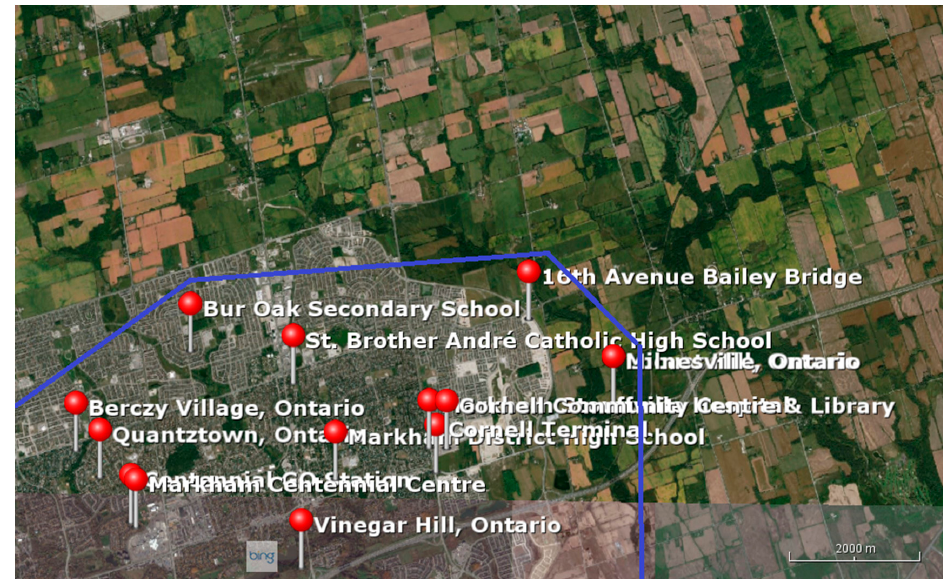
Figure 4. Fusion of multiple layers from different WMS servers: ( a ) LandSat7 photograph of Toronto, ( b ) OpenStreetMap roadmap, ( c ) OpenStreetMap map superimposed over a LandSat photograph, and ( d ) After analyzing using Planisphere.